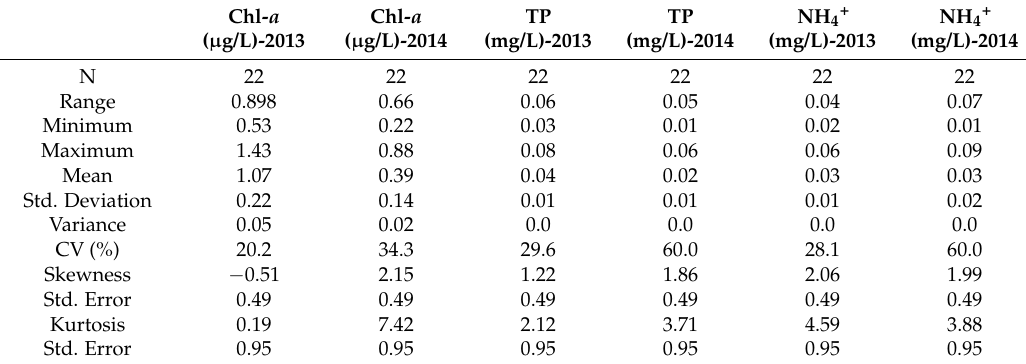
Figure 4. ( a ) Temporal boxplots presenting basic descriptive statistics (median, percentiles, min ‐ max, outliers and extremes) over sampling season of chlorophyll ‐ a and ( b ) Total phosphorus concentrations. Table 4. Descriptive statistics-Summary tables of in-situ Chlorophyll- a , Total phosphorus and ammonium concentrations of 2013 and 2014.